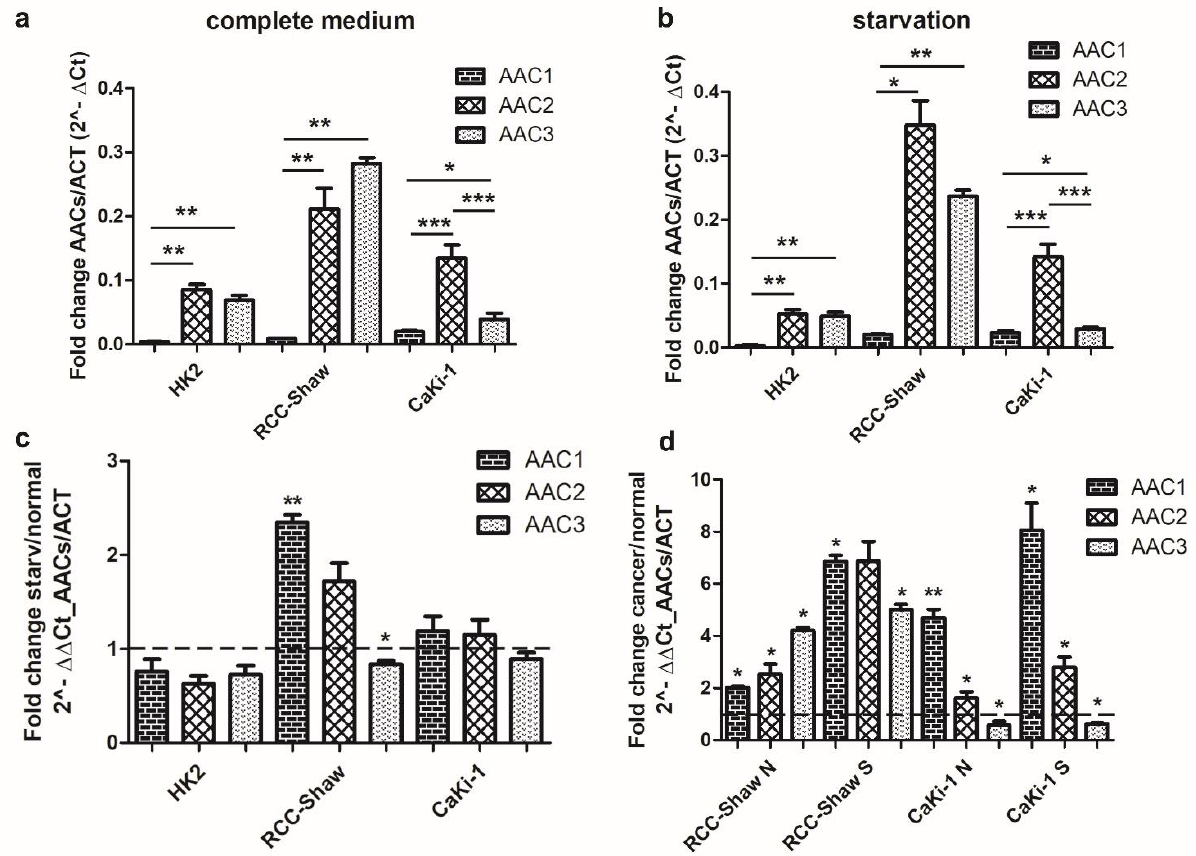
Figure 2. qRT-PCR of AAC1, AAC2, and AAC3 in non-cancer kidney cells (HK2) and cancer (CaKi-1 and RCC-Shaw) cells. Comparison of the AAC1, AAC2, and AAC3 gene expression levels between cells grown in complete medium ( a ), cells grown in serum-deprived medium ( b ), cells grown under starved (serum-free) conditions vs. normal (complete medium) conditions ( c ), and cancer cells vs. non-cancer cells are reported ( d ). Panel d: “N” indicates normal (complete medium) growth conditions, “S” indicates starved (serum-free) conditions. Data are presented as mean + SE of at least three independent experiments. The reported AAC expression levels were normalized to the nuclear housekeeping ACT gene. * p < 0.05; ** p < 0.01, *** p < 0.001, nonparametric Wilcoxon two-tailed test between starved and physiological conditions. “Starvation” indicates cells grown in a serum-free medium. “ACT” indicates actin.